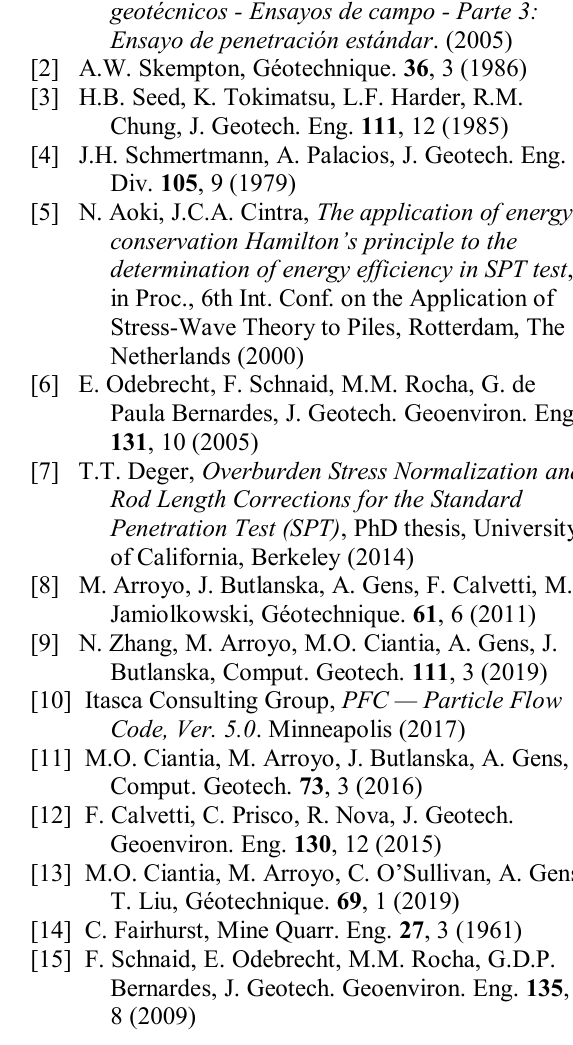
Fig. 4. (a) Hammer impact energy W H , rod potential energy U R and delivered energy E blow normalized by the theoretical maximum driving energy versus rod length; (b) raw and normalized blowcounts versus rod